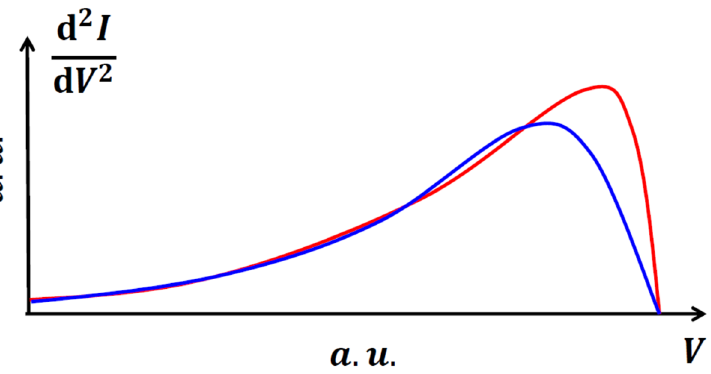
Figure 3. The hysteresis in the second derivative of the IVCP, which is related to its curvature, caused by the temperature change of the probe during its measurement process. The red curve corresponds to decreasing potentials, while the blue one corresponds to increasing potentials (authors’ experimental measurement).